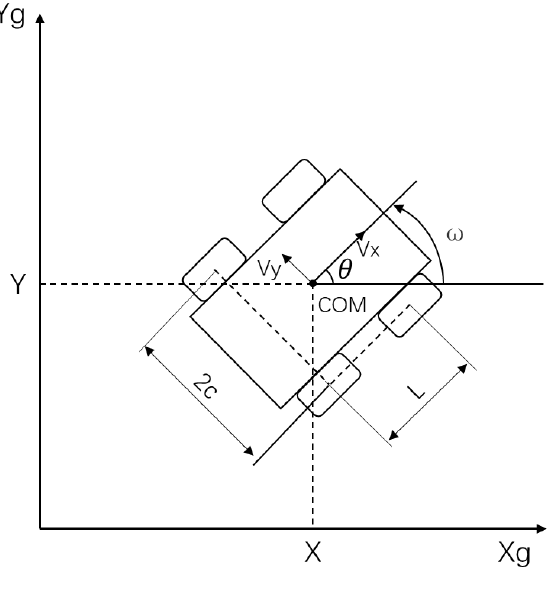
Figure 4. Kinematic model of the robot.